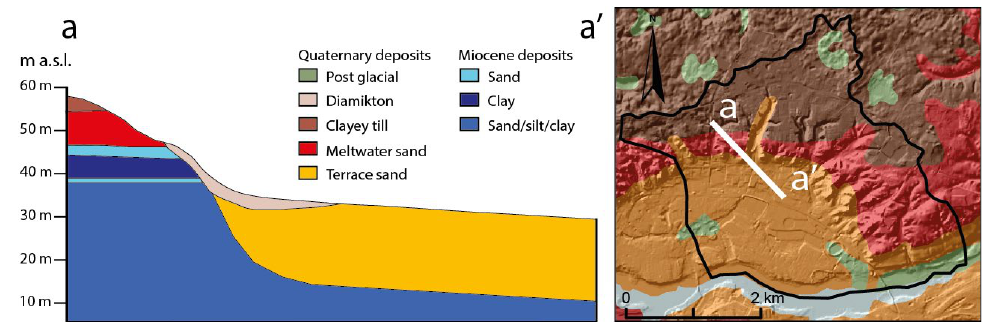
Figure 2. Conceptual geological model based on Jakobsen et al. [30]. The right side shows the location of the profile and the surface geology. The Miocene succession, illustrated with blue colors, consists of (from the top): sand (Addit member), and below from the Vejle Fjord Formation, clay, sand, and fine sand/silt/clay layer. The geological profile a-a’ shown to the left are marked as a white line a-a’ on the map to the right.